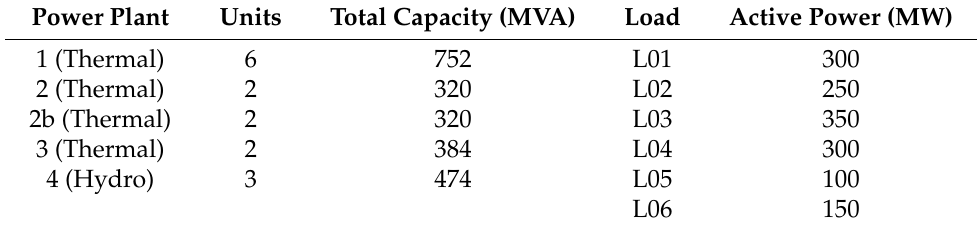
Table A1. Generator and load data for the utility grid.